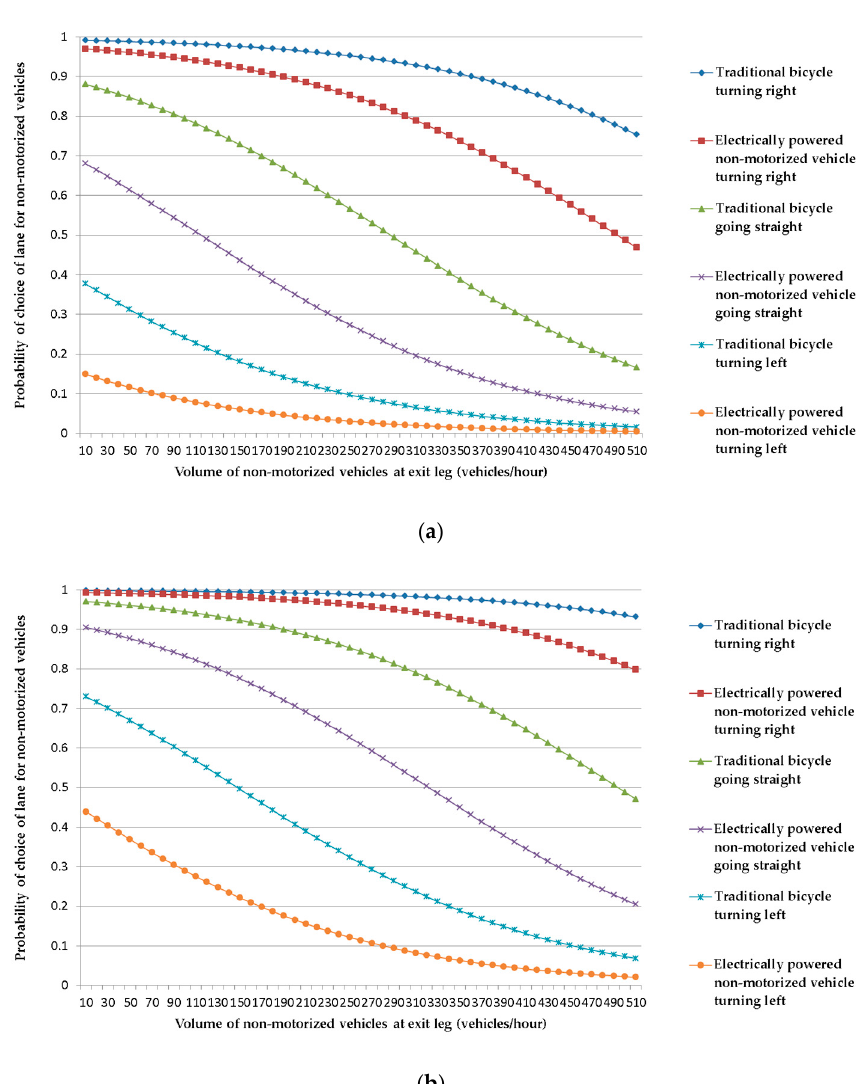
Figure 5. Probability curves of lane choice of female riders of non-motorized vehicles. ( a ): Width of lane for non-motorized vehicles being 1.5 m; ( b ): width of lane for non-motorized vehicles being 3.75 m.